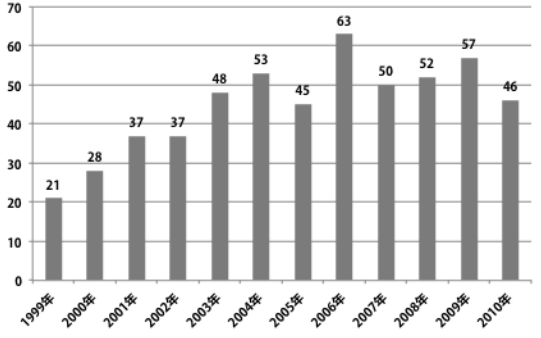
Figure 1. Number of Participants from 1999 to 2010